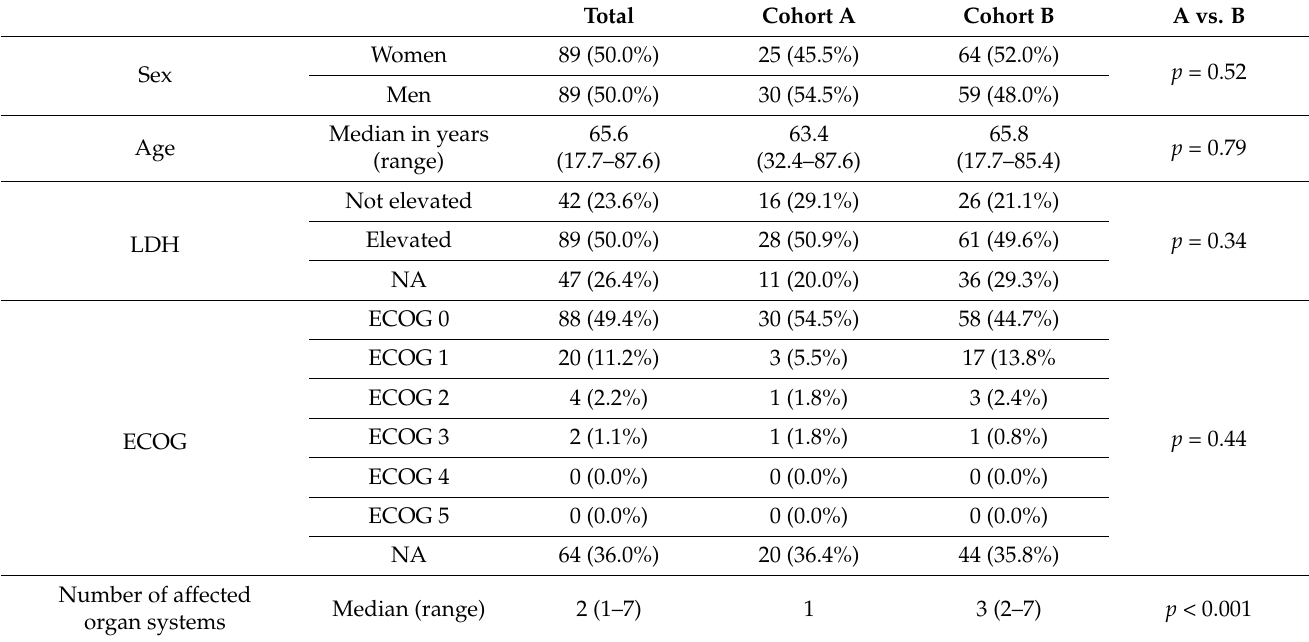
Table 1. Characteristics of the study population. Abbreviations: NA = not available, ICB = immune checkpoint blockade. Total Cohort A Cohort B A vs.